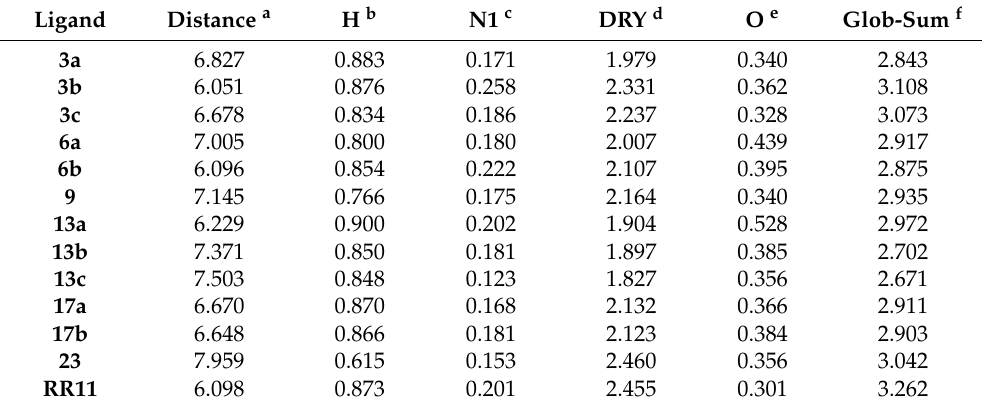
Table 3. Scores obtained for the SBVS of the new inhibitors in h COX-1 crystal structure (PDB ID: 6Y3C) performed with the FLAP software.